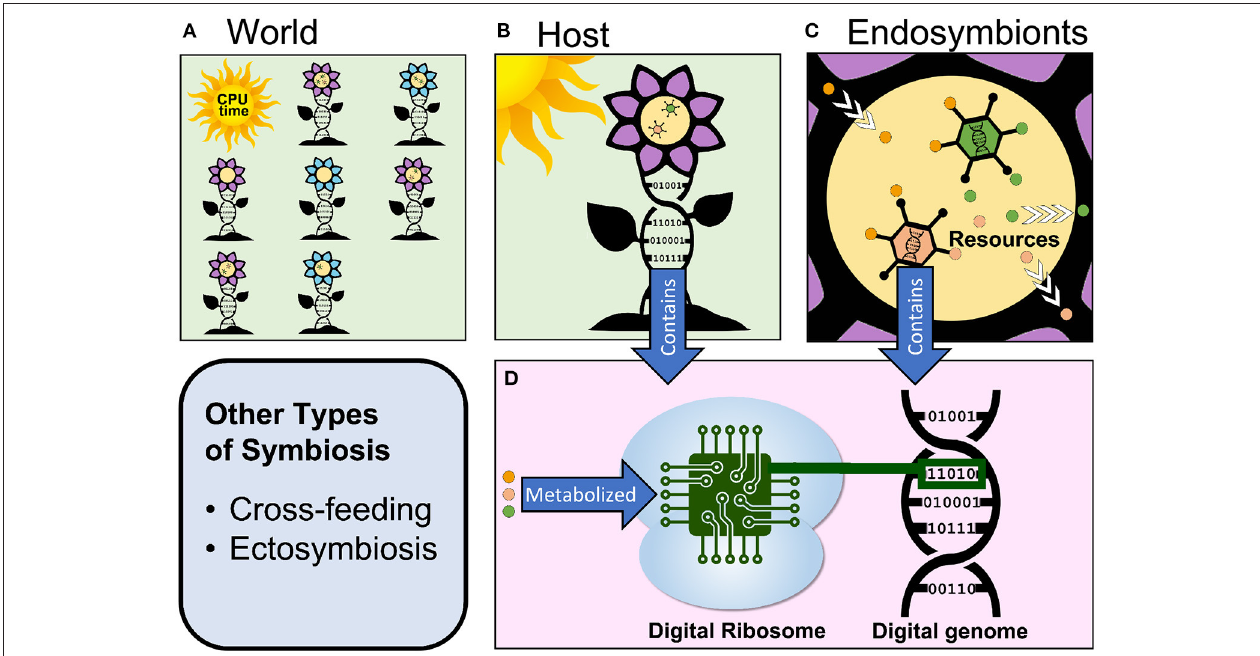
FIGURE 1 | Overview of the components of a hypothetical digital evolution system that supports endosymbiosis. (A) A virtual world contains computational organisms of different phenotypes and provides them with space (in the computer’s memory) and resources (CPU cycles in this example). (B) Each host organism has a digital genome and can contain one or more endosymbionts. The host takes in resources from the environment. (C) Endosymbionts each have a digital genome as well, exist inside of their host, and might metabolize some of the resources that their host takes in. (D) Every host and endosymbiont’s digital genome is processed by a digital ribosome to produce the organism’s phenotype. This process requires resources to